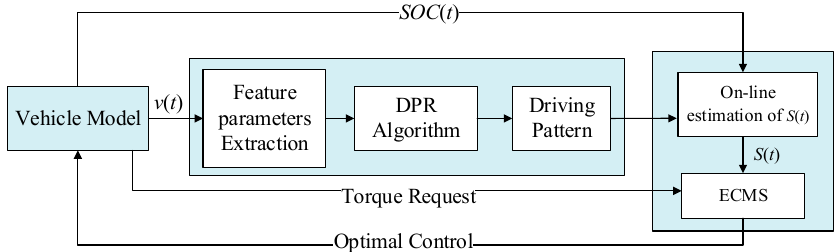
Figure 8. Schematic diagram of the adaptive equivalent consumption minimization strategy (A-ECMS).